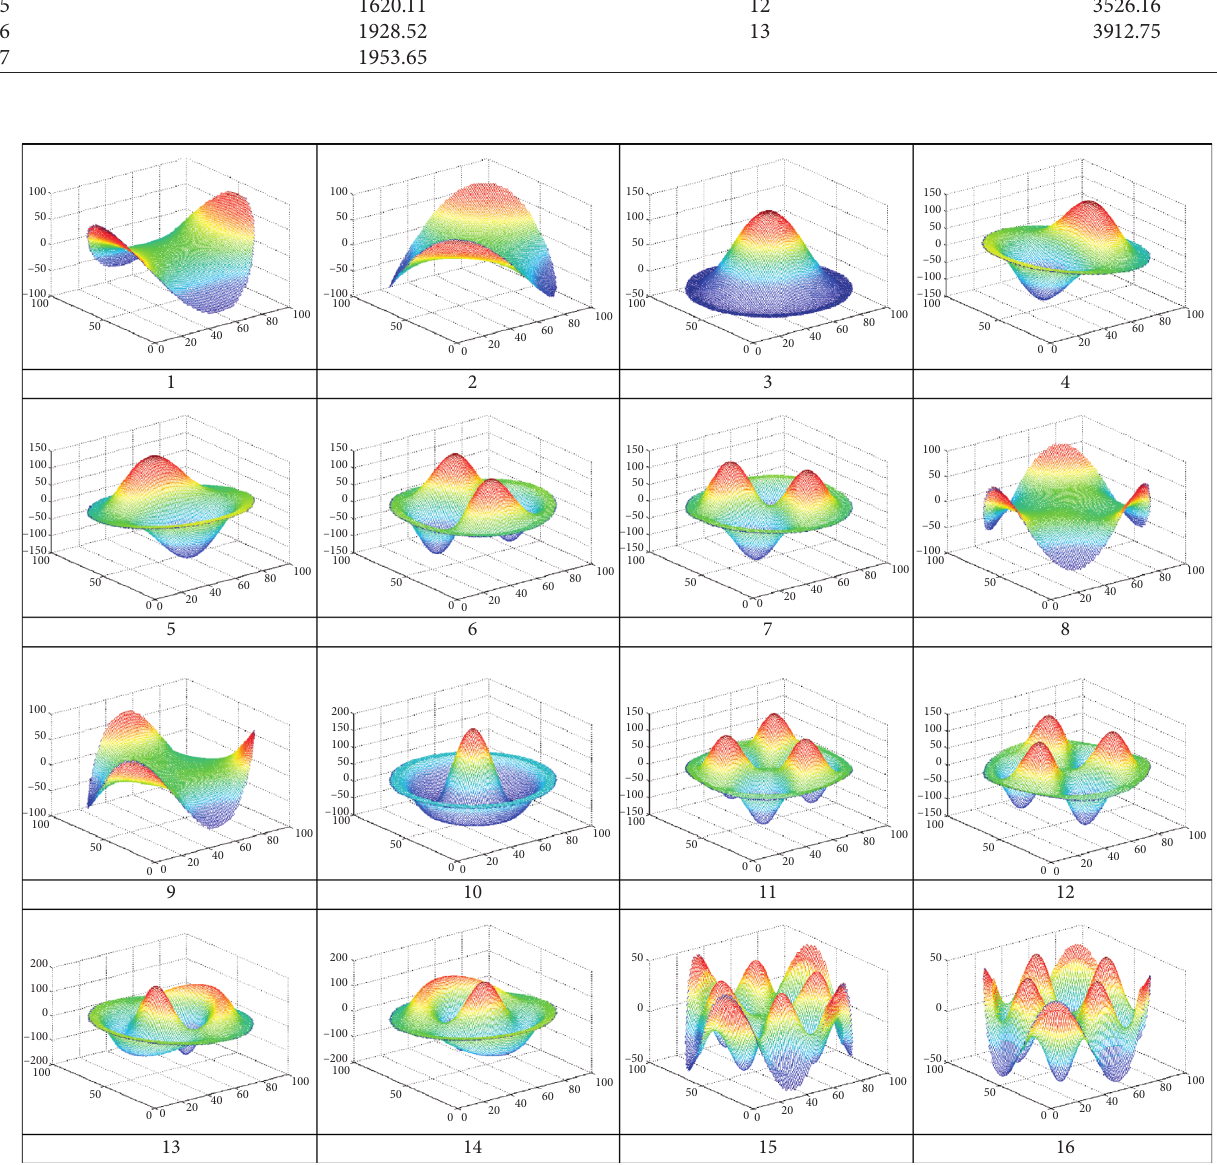
Figure 13: Vibration mode shape predictions from the FE model of the